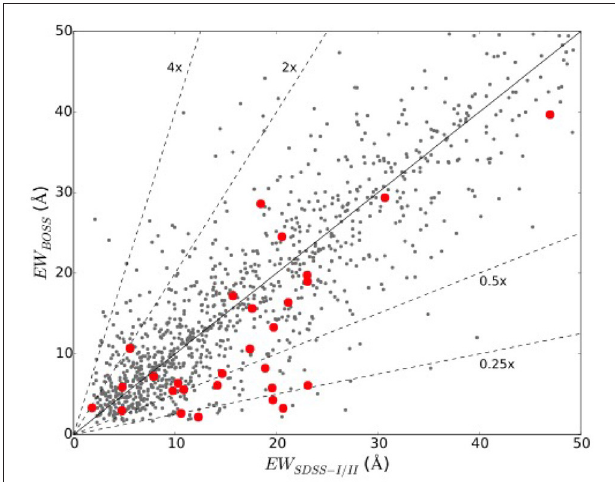
FIGURE 3 | EWs at two different epochs for the sample of additional non-disappearing BALs in the spectra where disappearances are detected (large red dots). For each BAL trough, the two EWs are measured in the same epoch pair where disappearance is detected. Small gray dots in the background represent the EWs at two epochs (one from SDSS-I/II and one from BOSS) for all the sources in the main sample, measured from the most-recent SDSS-I/II epoch and the least-recent BOSS epoch for each source. The solid line indicates where the EWs of the two compared epochs are equal, while the dashed lines indicate where the EW of the BOSS epoch is four times, two times, half of, and a quarter of the EW in the SDSS-I/II